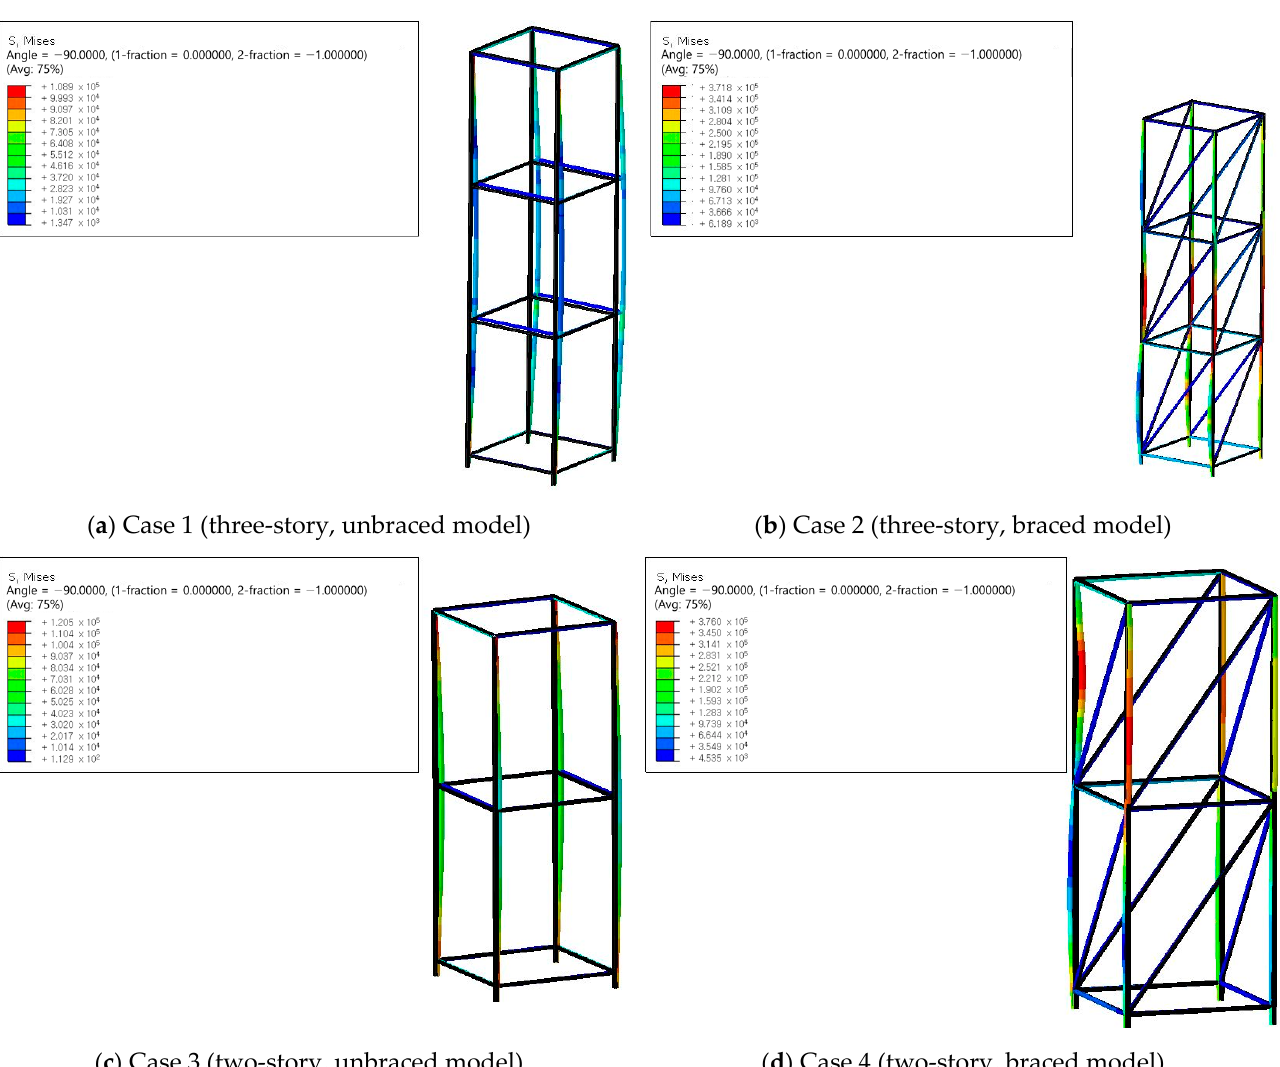
Figure 17. Deformation of the specimen through nonlinear inelastic structural analysis.